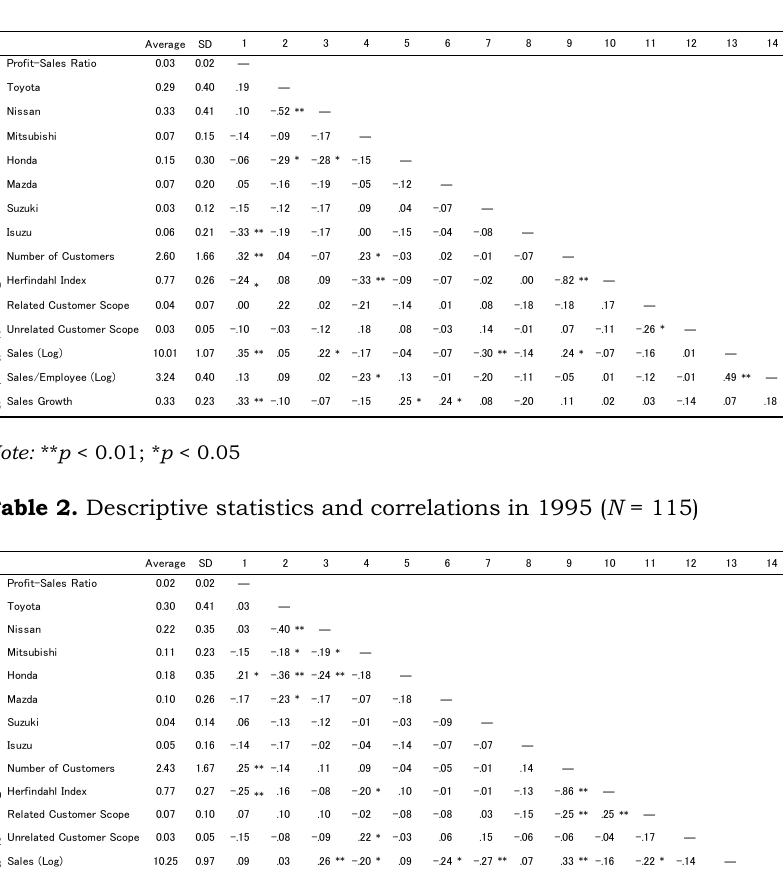
Table 1. Descriptive statistics and correlations in 1985 ( N = 78)